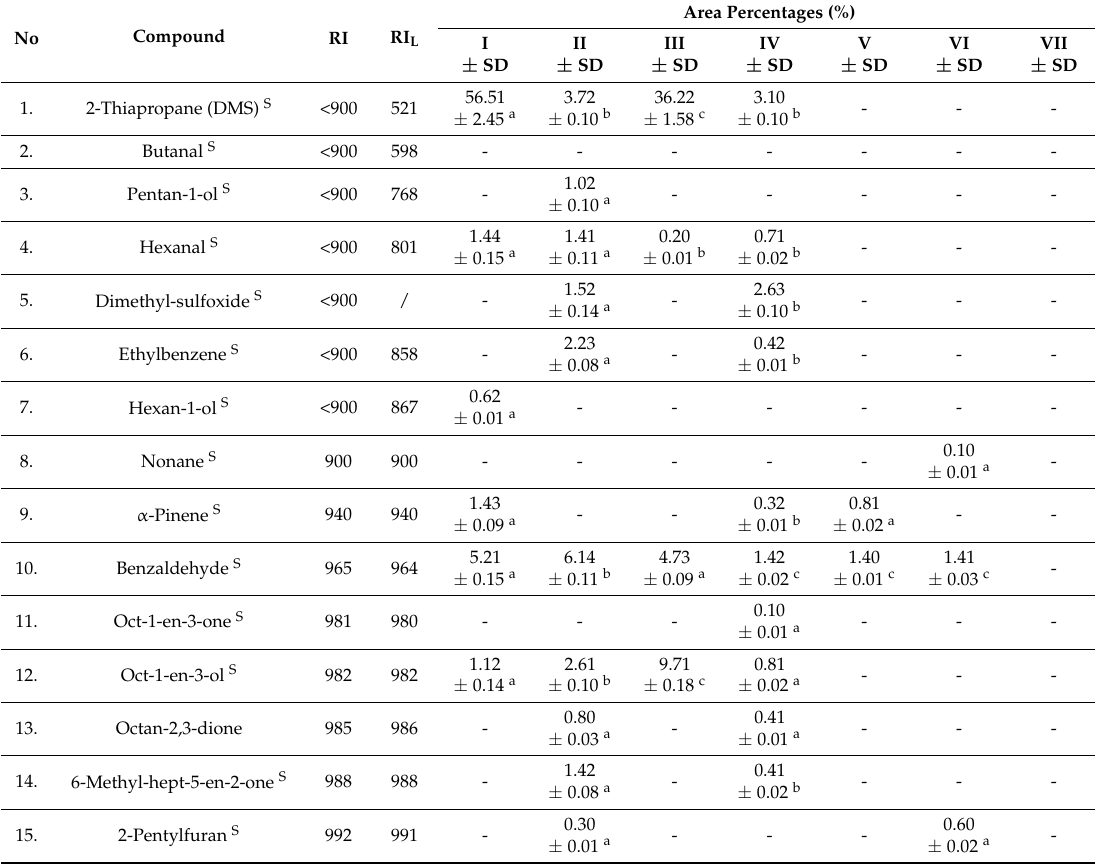
Table 1. The volatile compounds from Codium bursa isolated by headspace solid-phase